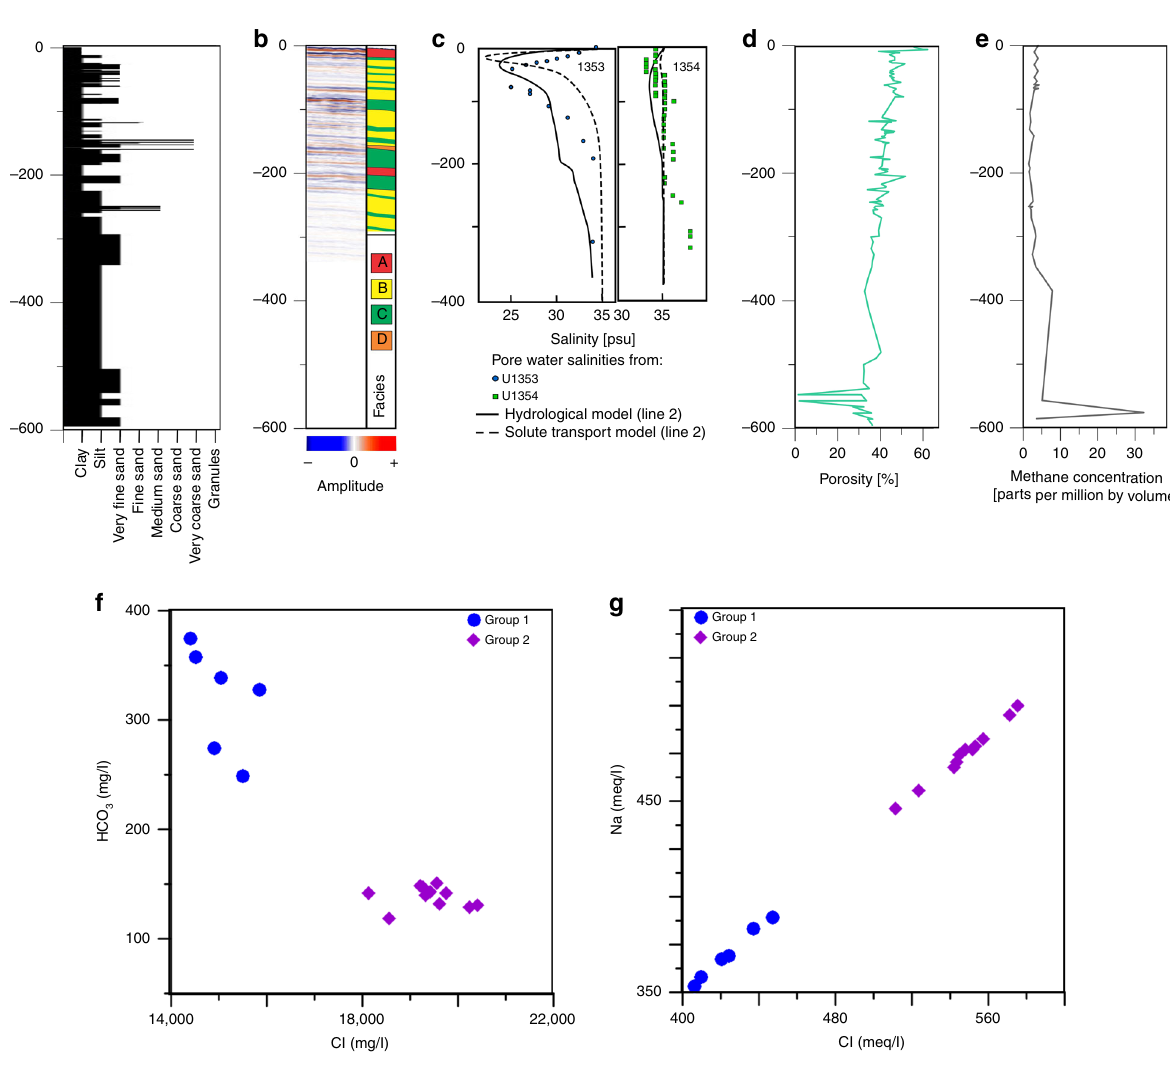
Fig. 2 Borehole U1353 data. Depth pro fi les of a sediment grain size, b seismic re fl ection data (from TAN1703 survey) and interpreted facies, c pore water salinity, d porosity, e methane concentration, f plots of HCO 3 vs. Cl and g Na vs. Cl. Pore water salinity pro fi les, derived from the hydrological model (solid line) and the model for solute transport by vertical diffusion (dashed line) for the site of boreholes U1353 and U1354, are included in c